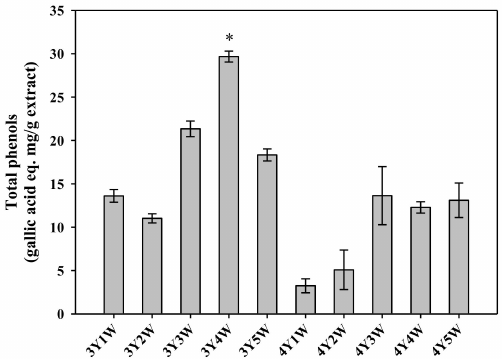
Figure 3. Total phenolic contents of ginseng berry extracts harvested at various time points. Rectangular bars and their error bars represent means and standard deviations, respectively ( n = 3). The ‘ m Y n W’ on the x-axis means m -year-old ginseng berry harvested in the n th week of July. *, significantly di ff erent from other